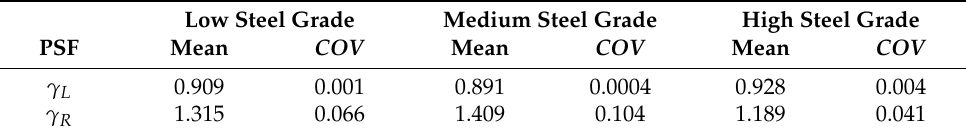
Table 6. Mean and COV of PSFs of intact pipes of low, medium and high steel